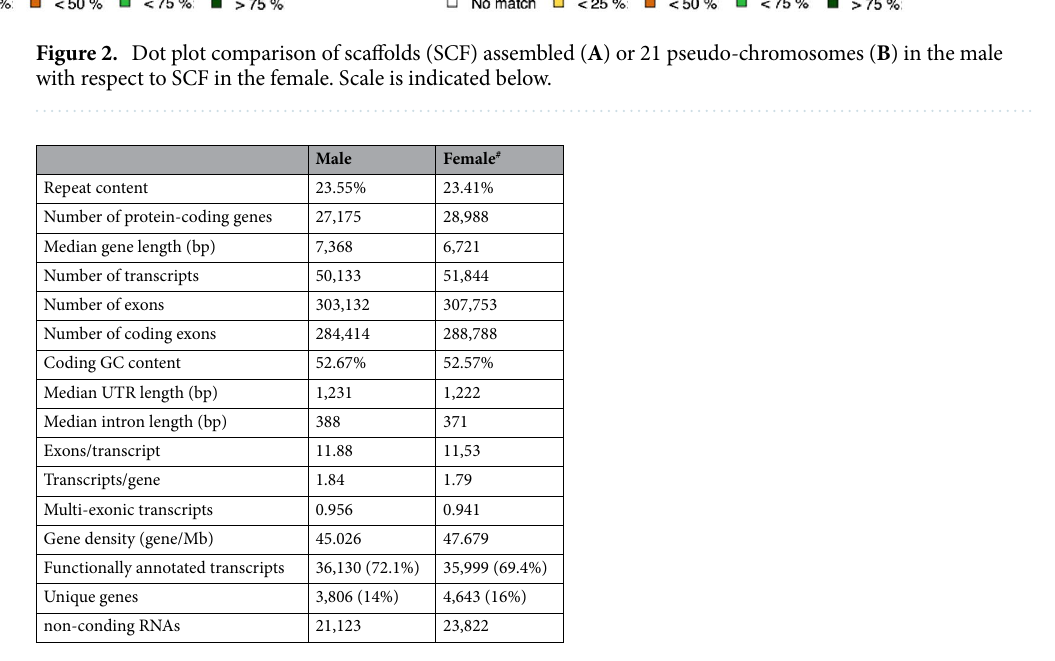
Table 2. Summary annotation statistics for male and female assemblies. Annotation pipeline is described with more details in “Supplementary method”. # Sequence deposited in figshare https:// doi. org/ 10. 6084/ m9. figsh are. 12472 100.